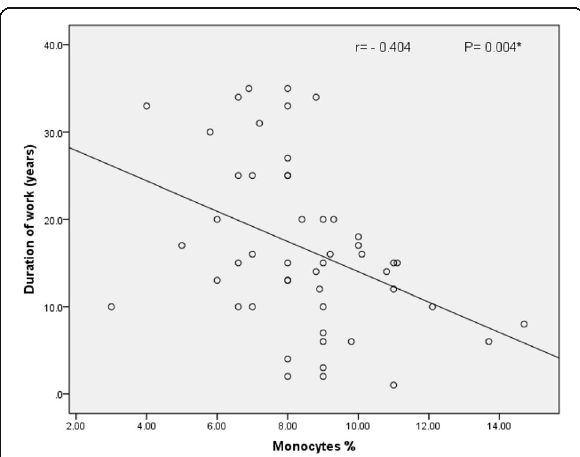
Fig. 3 Correlation between duration of work and monocytes